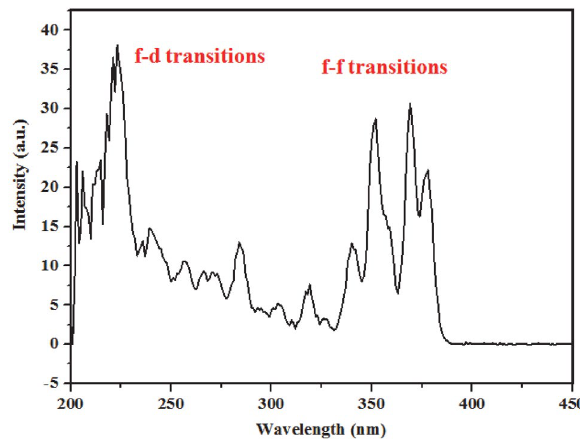
Figure 12. Excitation spectra of YbPO 4 :Tb 3+ nanostructures